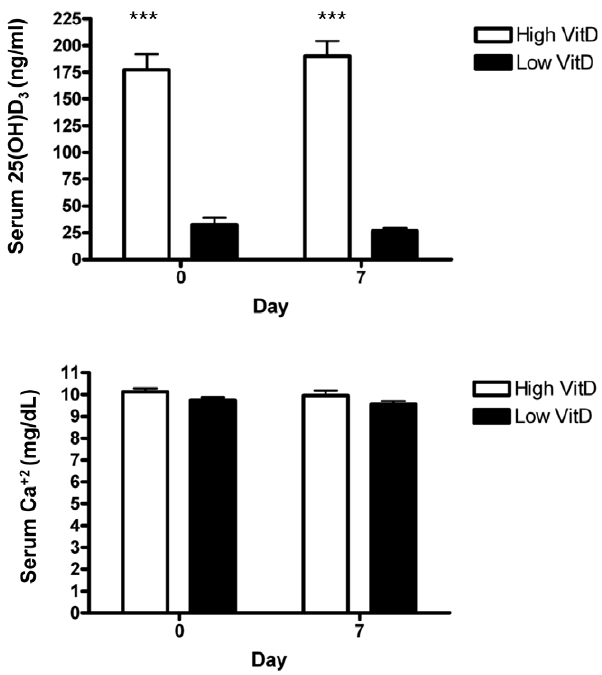
Figure 1. Serum 25(OH)D3 and Ca + 2 concentrations in calves at the beginning and the termination of the bovine RSVexperi- mental infection. Calves (n=8 per treatment group) were maintained on diets containing 1700 IU of vitamin D/kg (low vitD) or 17,900 IU of vitamin D/kg (high vitD) for ten weeks prior to experimental challenge. Calves were challenged via aerosol inoculation with bovine RSV. Blood samples were collected from each calf on the day of experimental challenge and just prior to euthanasia. (A) Serum 25(OH)D 3 was quantified by radioimmunoassay and data shown represent the mean 6 SE. Data were analyzed using Student’s t-test. ***P , .001. (B) Serum calcium was determined by atomic absorption spectrometry and data shown represent the mean 6